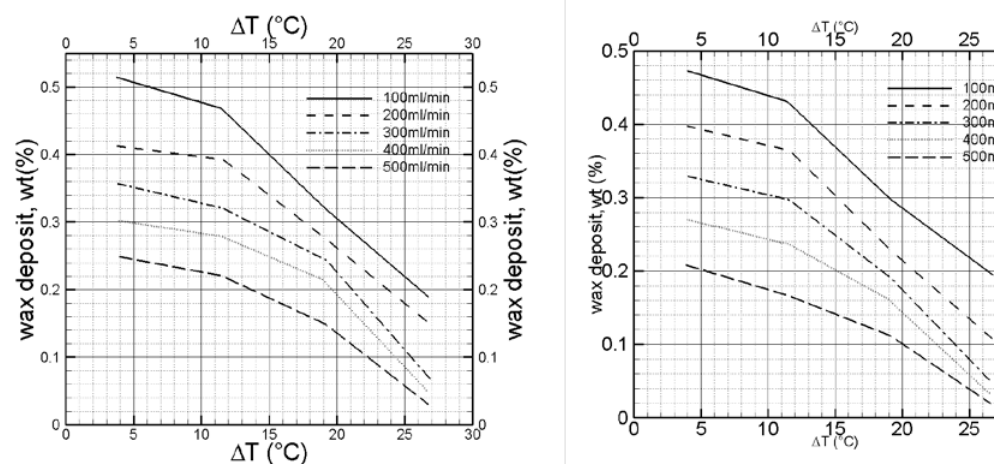
Figure 3 Effect on wax deposit (weight percentage) due to temperature differential at 9 min (kelechukwu et al., 2010)